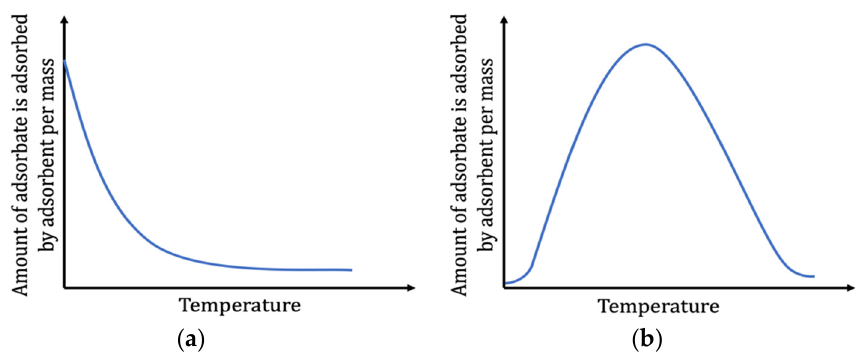
Figure 5. Effect of temperature on ( a ) physisorption and ( b ) chemisorption. From the aspect of adsorption isotherm that involves the principle of pressure, an increasing pressure will also intensify the adsorption process to a higher level until the adsorbent becomes saturated [33]. However, when the adsorption has reached the equilibrium level, the pressure will no longer play an important role in making the adsorption process more effective, no matter how much pressure is being applied on the process. Therefore, the general graph with pressure as a function is shown in Figure 6.